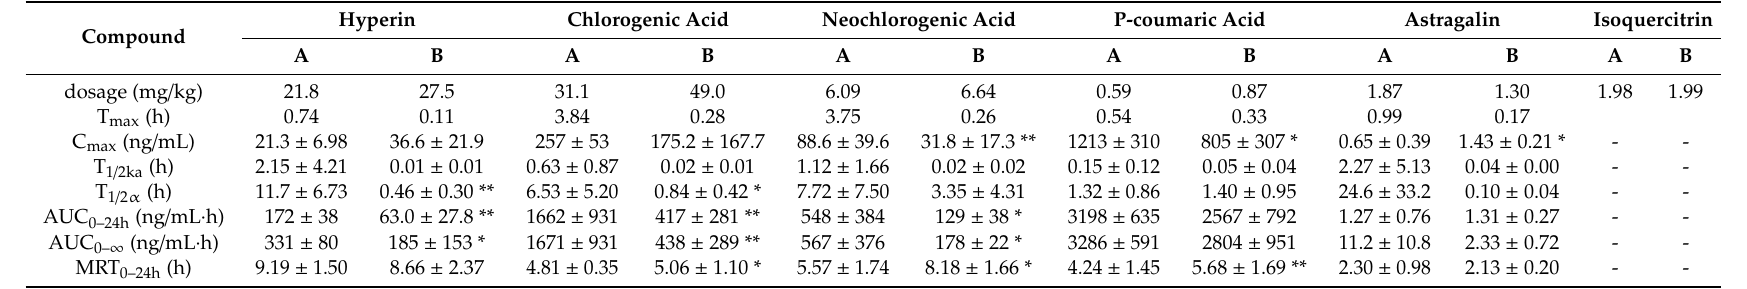
Table 5. Pharmacokinetic parameters of six compounds after oral administration of SF-CS and SP-CS extract ( n = 10, mean ±